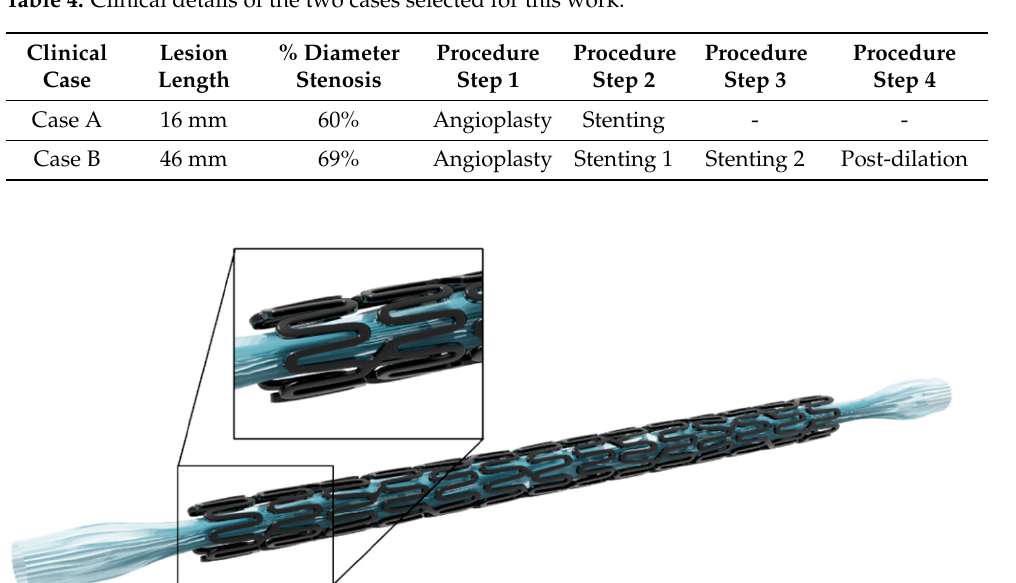
Table 4. Clinical details of the two cases selected for this work.